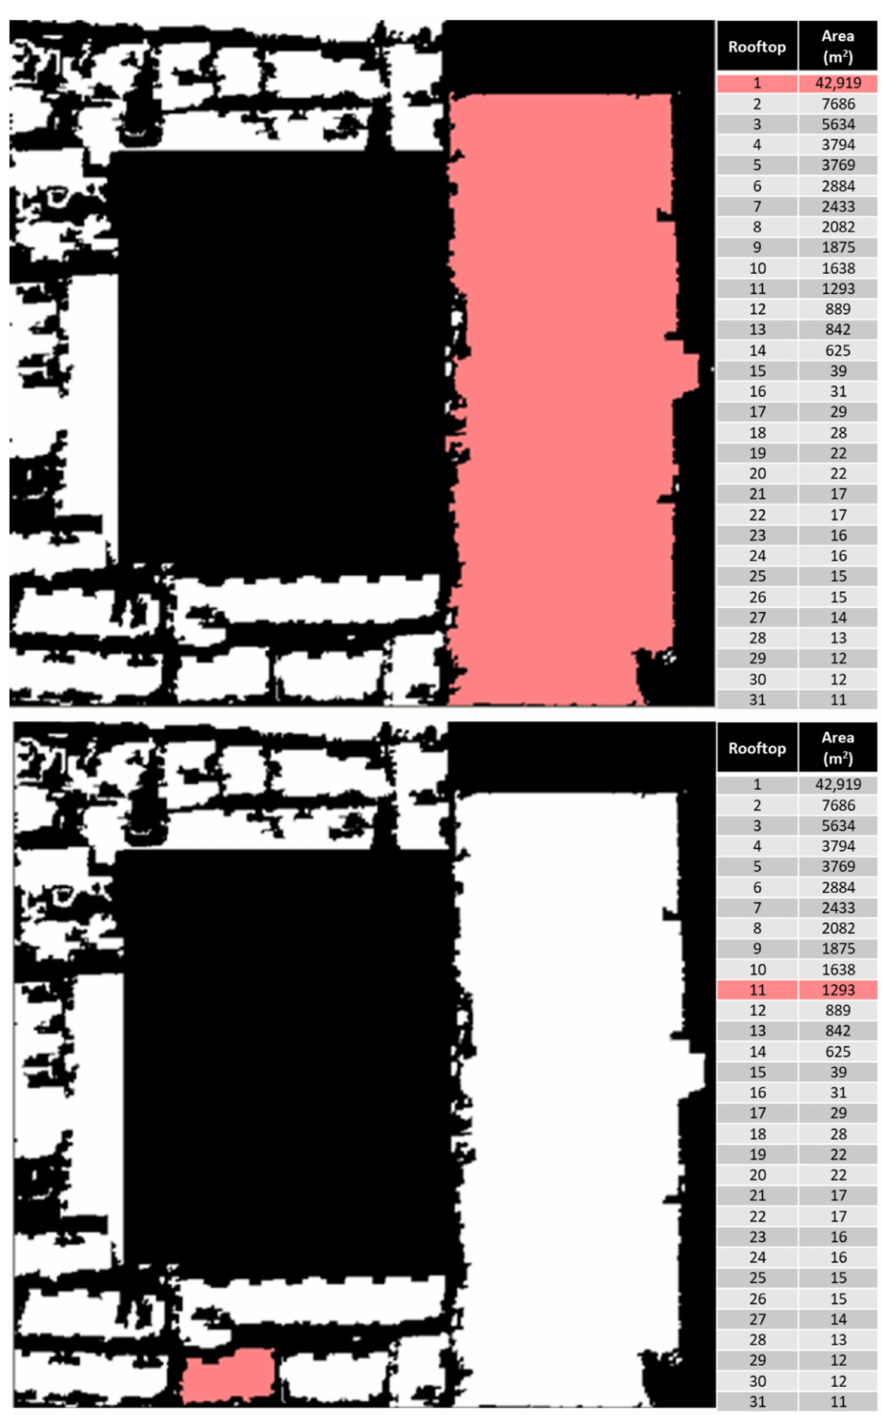
Figure 5. Example of unscaled areas of two structures used to calculate the percentage difference between the actual and detected rooftop